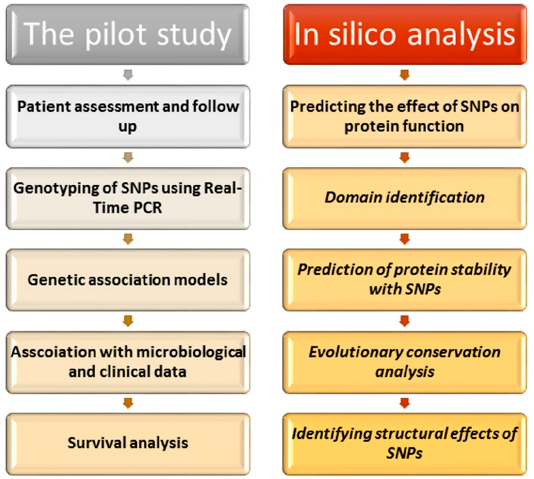
Figure 1. Scheme illustrating the outline of the study plan.